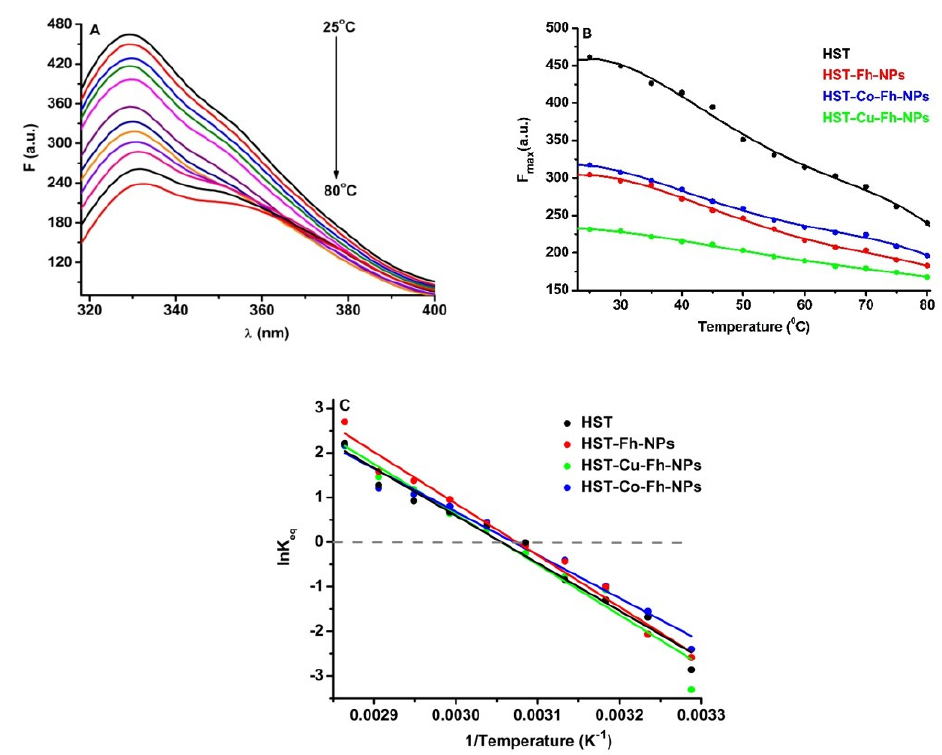
Figure 3. ( A ): The fluorescence corresponding to the thermal denaturation processes of HST (3 µ M), ( B ): Maxima of the fluorescence of HST in the absence and presence of simple and doped Fh-NPs (10 µ M), and ( C ): Graphical representation of ln K eq vs. 1/ T for the denaturation of HST structure the absence and presence of simple and doped Fh-NPs.